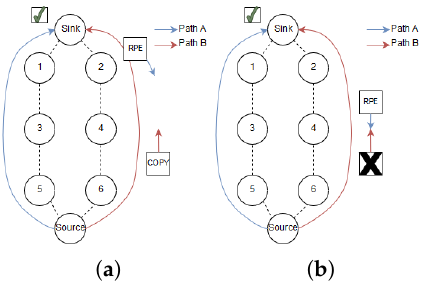
Figure 5. Illustration of RPE step 3 ( a ) and step 4 ( b